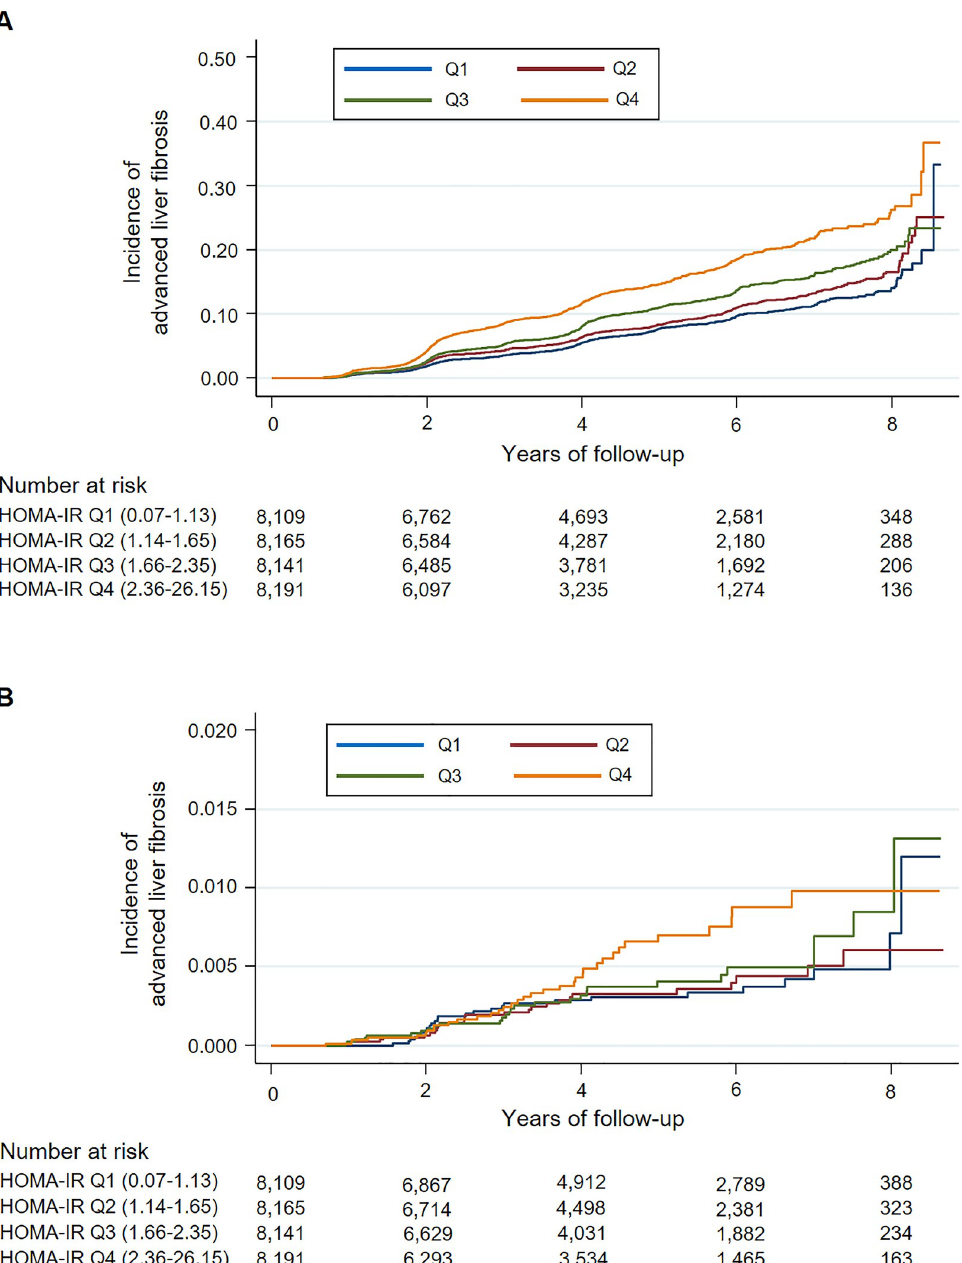
Fig 2. Cumulative incidence of advanced liver fibrosis by HOMA-IR quartile at baseline. (A) Above the intermediate fibrosis probability (APRI � 0.5), (B) With high fibrosis probability (APRI > 1.5). Abbreviations: HOMA-IR, homeostatic model assessment of insulin resistance; APRI, aspartate aminotransferase-to-platelet ratio index.